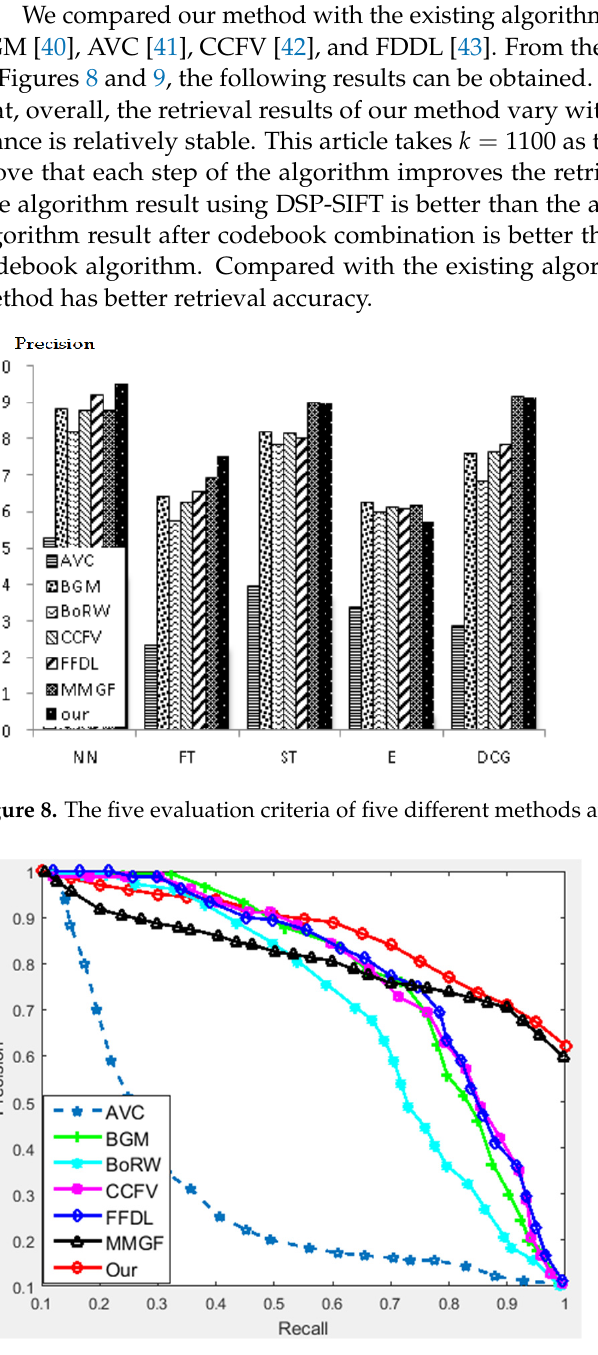
Figure 9. PR curve of five different methods and ours.